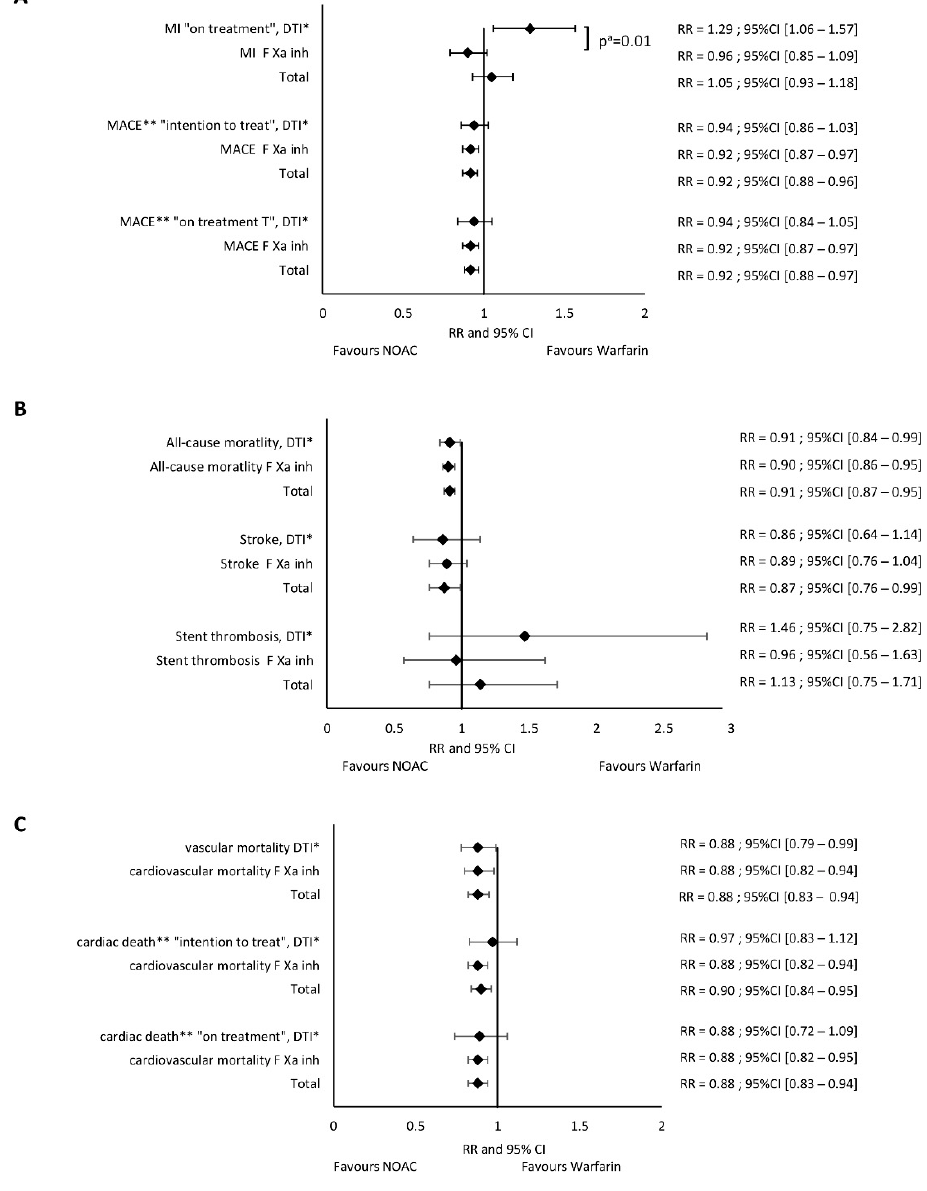
Figure 4. Forest plot of the relative risk of efficacy endpoints: ( A ): MI, MACE; ( B ): overall mortality, stroke, stent thrombosis; ( C ): cardiovascular mortality. a — p -value for subgroup differences; * direct thrombin inhibitor–dabigatran; ** results from the reanalysis of the RE-LY study [27] . In the sensitivity analysis, after excluding edoxaban 30 mg, the risk of MI in patients treated with FXa inhibitors did not change (Supplementary Figures S20, S24, and S28).